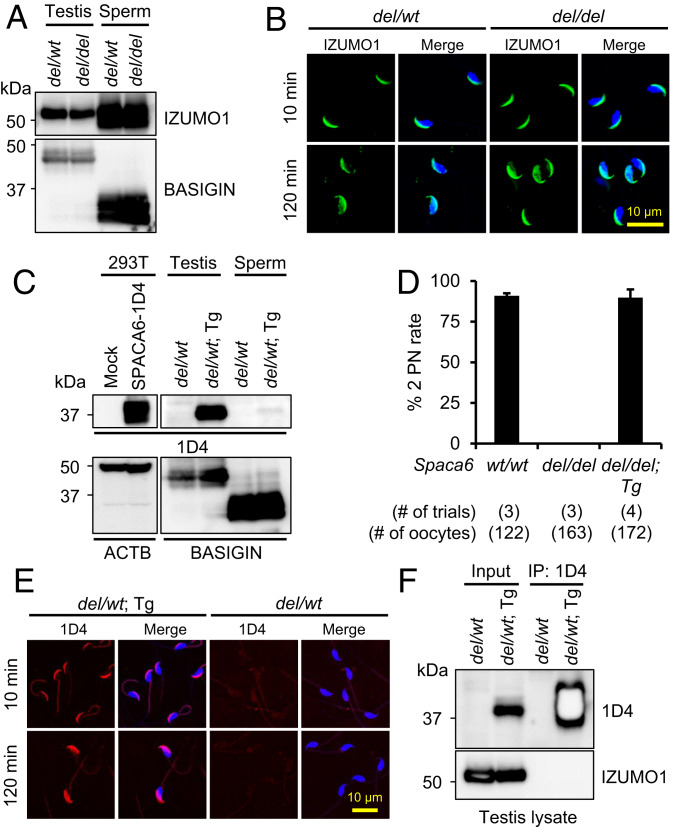
Analyses of Spaca6-1D4 Tg male mice. (A) Expression of IZUMO1 in Spaca6 KO spermatozoa. The expression of IZUMO1 was comparable in the testis and sperm lysates of del/wt and del/del males. The expression of BASIGIN was analyzed in parallel by immunoblot analysis as a loading control. (B) Localization of IZUMO1 in Spaca6 KO spermatozoa before and after the acrosome reaction. After 10 and 120 min of incubation in TYH medium, the localization of IZUMO1 in control and KO spermatozoa was visualized by immunocytochemistry. Sperm nuclei were labeled by Hoechst 33342. Same as control spermatozoa, IZUMO1 in Spaca6 KO spermatozoa was localized to the acrosome cap before acrosome reaction and translocated to the equatorial segment or the entire sperm head after acrosome reaction. (C) Expression of SPACA6-1D4 in testes and cauda epididymal spermatozoa of Tg male mice. Testis and sperm lysates from del/wt; Tg males (del/wt; Tg) were used to test Tg expression. HEK293T cells expressing SPACA6-1D4 were analyzed as a positive control, and the testis and sperm lysates from del/wt males were used as a negative control. The expression of ACTB and BASIGIN was analyzed in parallel as loading controls for the immunoblotting of HEK293T lysates and testis/sperm lysates, respectively. (D) Analysis of the fecundity of Spaca6 del/del; Tg males expressing SPACA6-1D4. Male mice were paired with hormone-treated wt/wt females, and oocytes were harvested from the females about 9 h after copulation. Spaca6 wt/wt and del/del males were analyzed as positive and negative controls, respectively. The fecundity of two Spaca6 del/del; Tg males were tested twice each (for a total of four trials). (E) Localization of SPACA6-1D4 in the spermatozoa of Tg mice before and after the acrosome reaction. After 10 and 120 min of incubation in TYH medium, the localization of SPACA6-1D4 in the spermatozoa of del/wt; Tg males was visualized by immunocytochemistry. Spermatozoa from del/wt males were analyzed in parallel as a negative control. The sperm nuclei were labeled by Hoechst 33342. SPACA6 was localized to the acrosome cap before acrosome reaction and spread out toward the equatorial segment after acrosome reaction. (F) Co-IP and Western blot analysis of the interaction between IZUMO1 and SPACA6. Testis lysate from del/wt; Tg males was incubated with anti-1D4 antibody-conjugated magnetic beads, and the eluted protein complex was separated by SDS/PAGE and analyzed by Western blot analysis. IZUMO1 was not detected in the co-IP product.